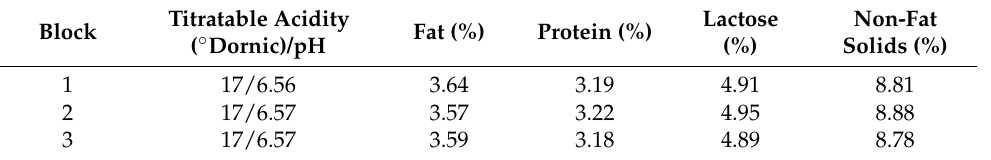
Table 1. Physicochemical values of fresh raw milk before ultrasonication [13].